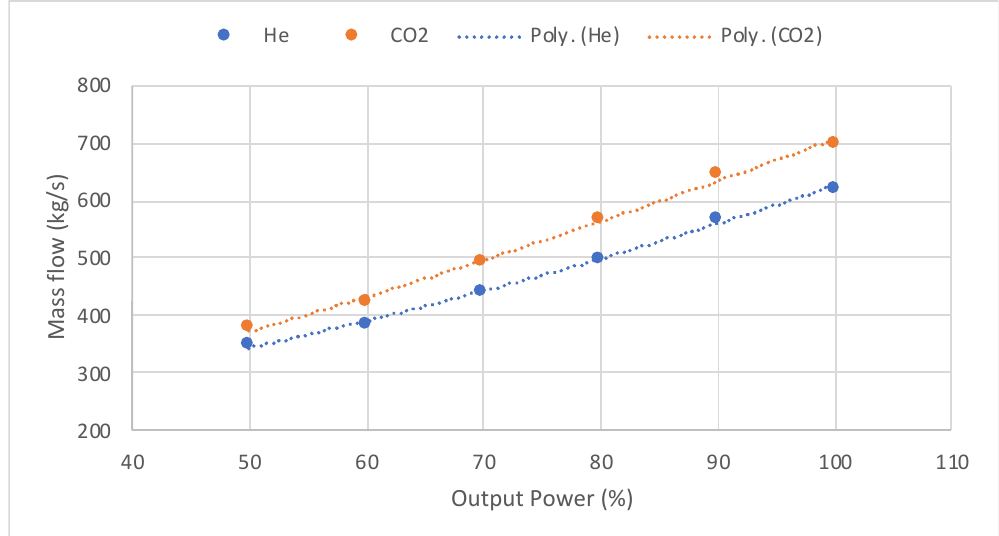
Figure 3. Mass-flow-rate demand of helium and carbon dioxide cycles when producing electricity, between 100% and 50% power demand. The debited mass-flow rate is utilised for hydrogen pro- duction via a control valve as part of a system, which detects signal based on grid-power demand.